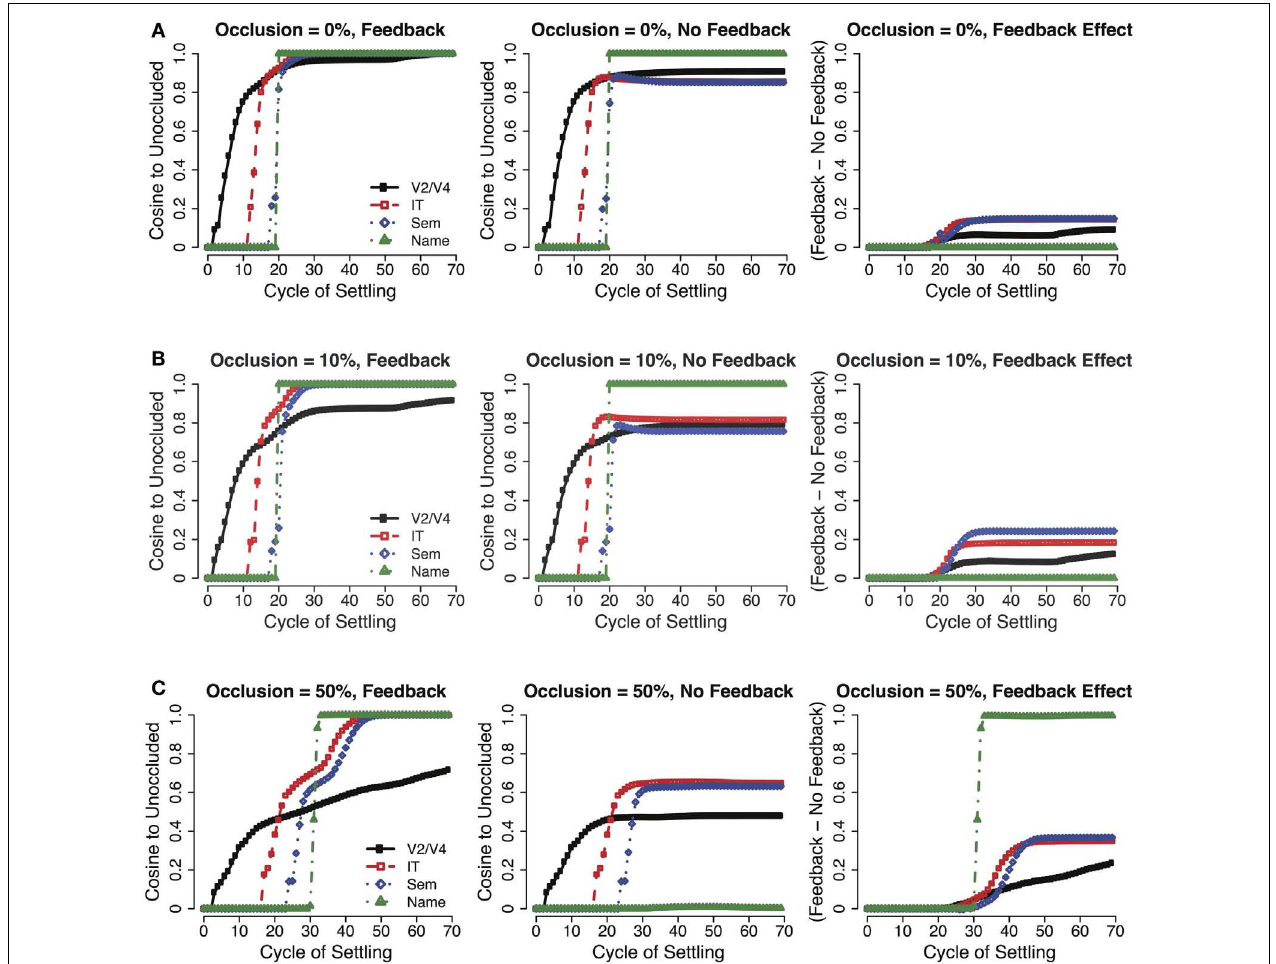
missing information reinforce the overall network state. In this case, the latency between the first IT responses and activation of the correct output is longer (ca. 15 cycles), in accordance with the recurrent interactions between layers, which take time to stabilize. Also note that theV2/V4 state does not fully complete, but the IT and Semantics patterns are identical to the unoccluded case, indicating that the higher-levels of the network complete, while the lower-levels do not (“amodal completion”). Recurrent excitatory feedback plays a critical role in this completion effect, as is shown in comparison with a network having no top-down feedback weights – this effect is more apparent with higher-levels of